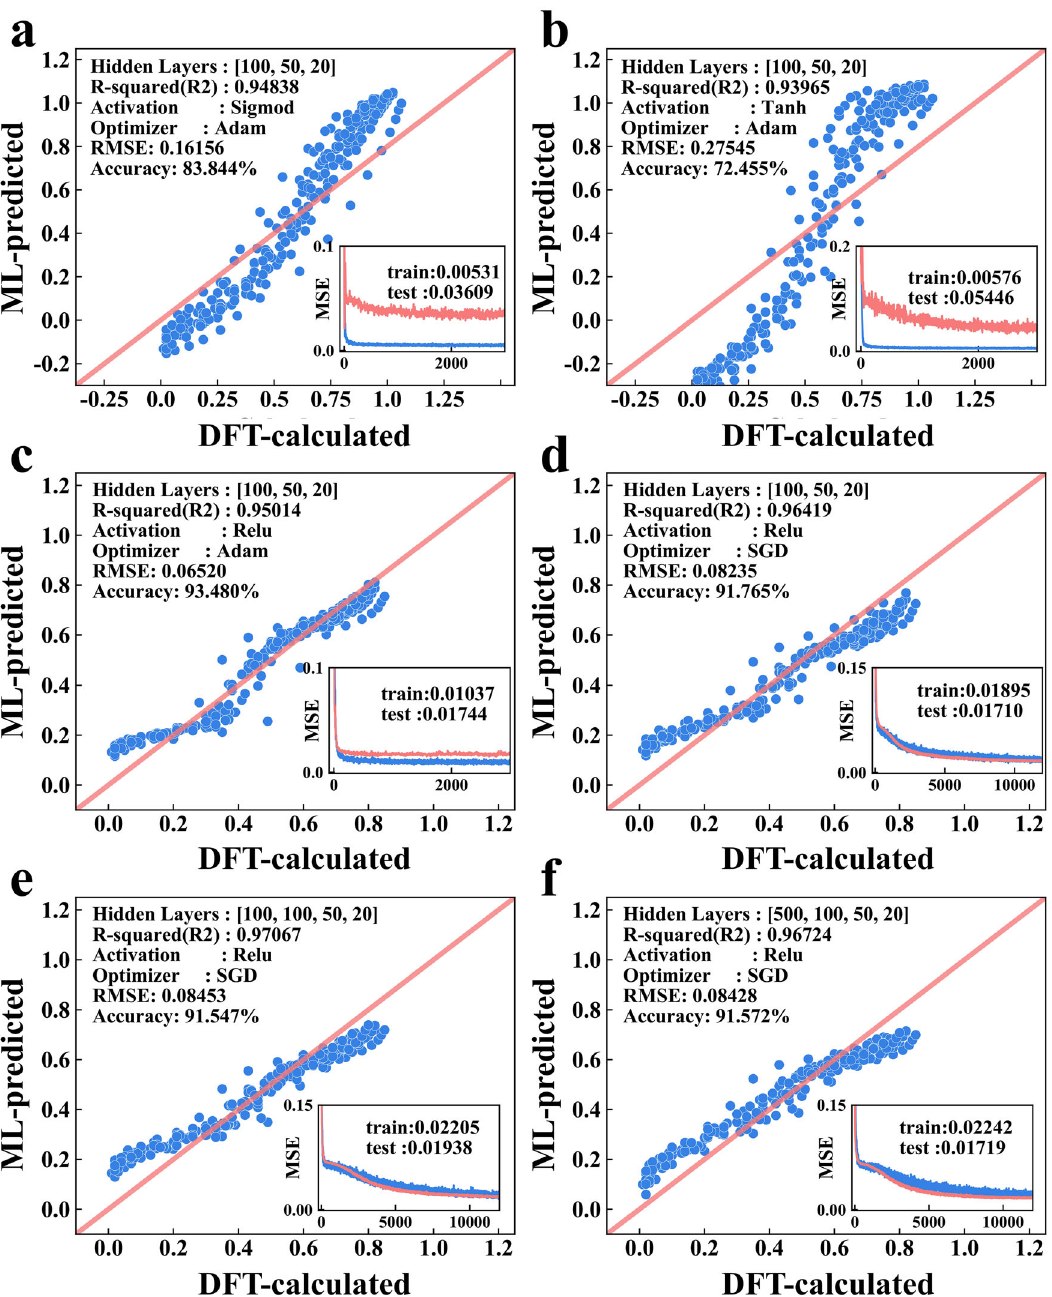
Fig. 2 Machine learning model. ML-predicted ZT max based on the deep neural networks with different activation functions, optimizers, and hidden layers, in comparison with the DFT-calculated values. a - c ML models using Adam optimization algorithm, three hidden layers of [100, 50, 20] and a Sigmod, b Tanh, or c Relu activation functions. d-f ML models using Relu activation function, SGD optimization algorithm and d three hidden layers of [100, 50, 20], e four hidden layers of [100, 100, 50, 20], or f four hidden layers of [500, 100, 50, 20]. The insets indicate the convergence process and mean square error (MSE) during training (blue line) and testing (red